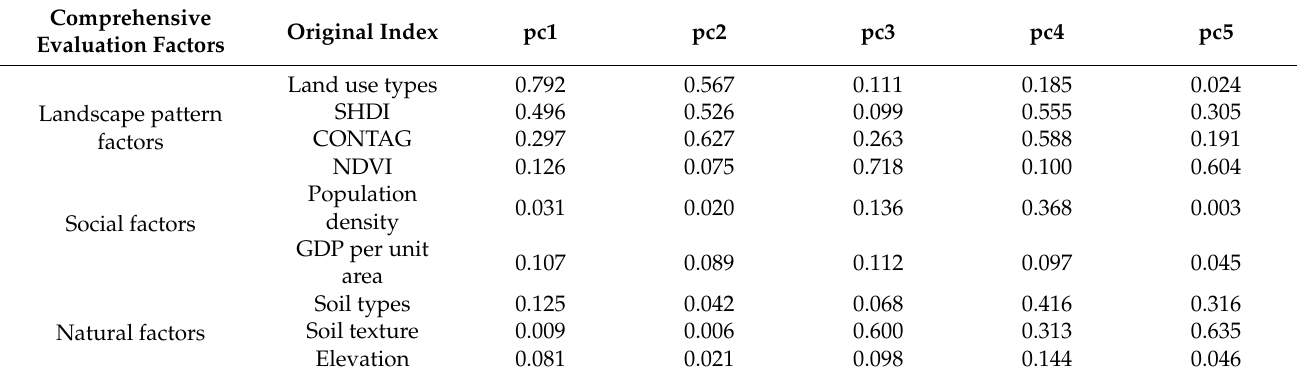
Table 4. Load matrix of each principal